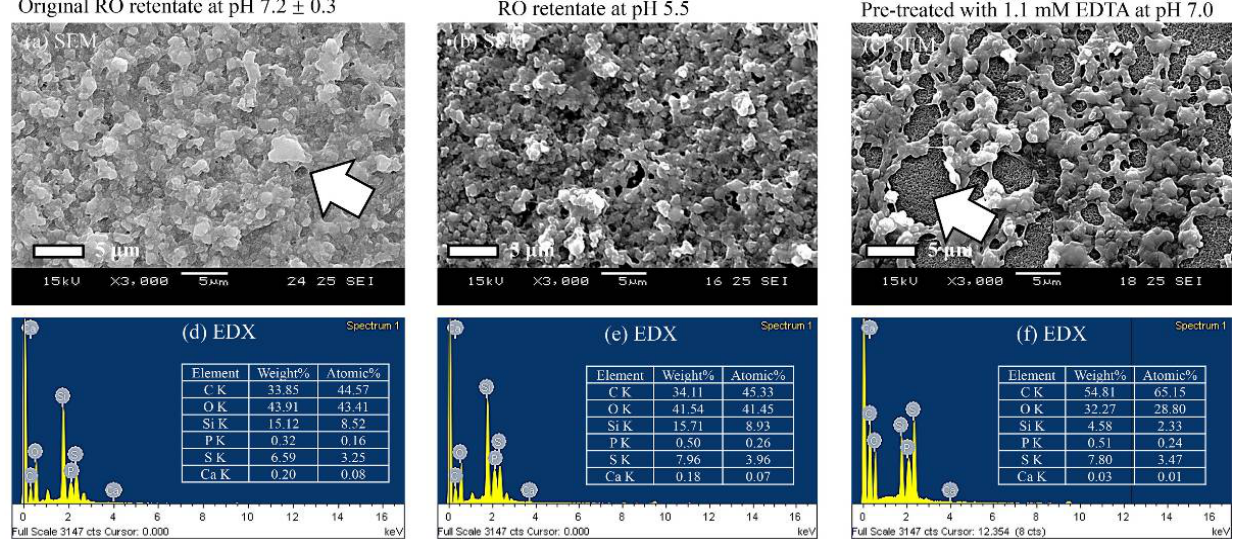
Figure 4. SEM-EDX and XPS images of the outer surface of the layer of fouled membrane, using the original RO retentate with pH 7.2; RO retentate at pH 5.5; pretreated RO with 1.1 mM EDTA as the feed [63].